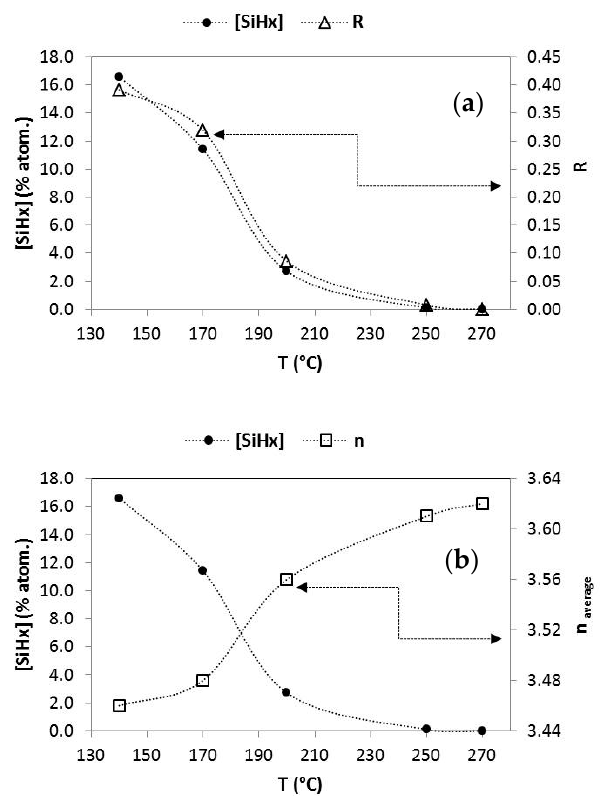
Figure 3. Evolution of the polyhydrides content and ( a ) R factor and ( b ) average refractive index, in the functioning of the deposition temperature of hydrogenated amorphous silicon thin films.